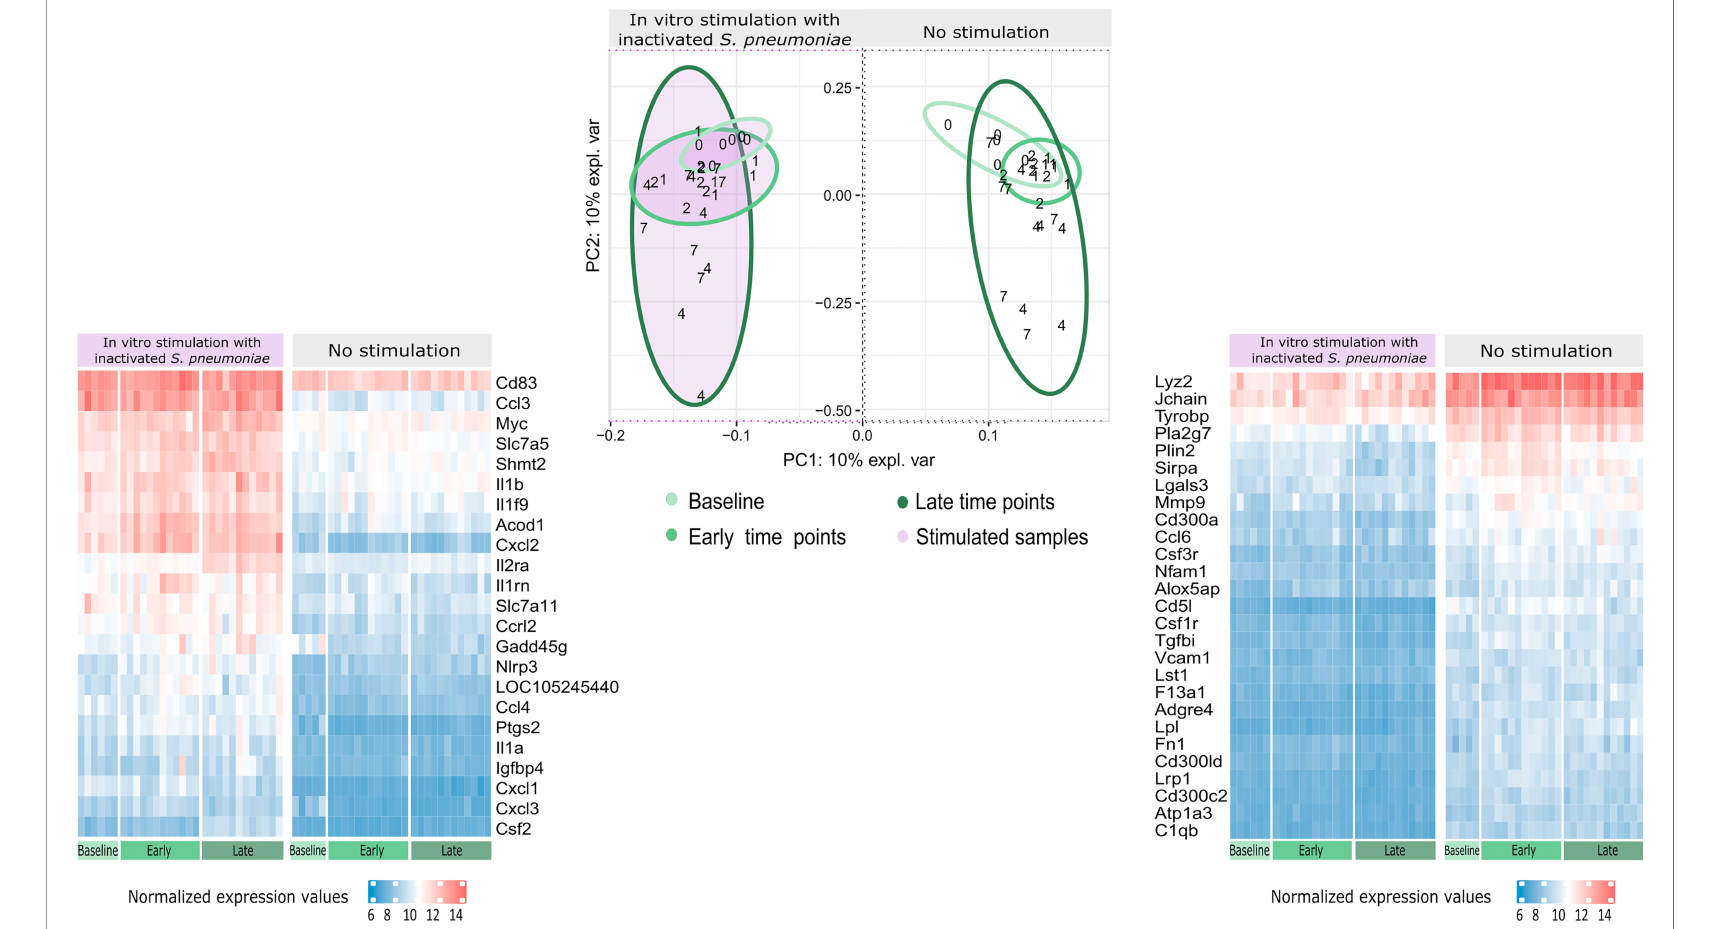
FIGURE 3 | Distribution of gene expression data and changes after stimulation. The sIPCA proposed by MixOmics revealed two main clusters, one formed by stimulated samples (shaded in purple) and other formed by unstimulated samples. The IPC1 (x-axis) represents the variance between stimulated and unstimulated samples of infected and non-infected mice. IPC2 (y-axis) shows the variance between baseline samples with respect to the other groups in different study days (1, 2, 4, 7). After infection, samples from days 1 and 2 (early time points) form a smaller cluster closer to baseline samples (lighter green), while samples from days 4 and 7 (late time points) present a higher dispersion (darker green). The normalized expression values for the 50 most important genes selected by the sIPCA in the fi rst component were represented in heatmaps, with lower values represented in blue and higher values in red and time points represented in the bottom part, following the same green scale of the sIPCA. The heatmap on the right, shows the 27 genes positively correlated with the fi rst component, which include positive and negative regulators of the immune system and drive the formation of the cluster of unstimulated samples. The heatmap on the left shows the 23 genes negatively correlated with the fi rst component, driving the stimulated samples to form a separate cluster. Most of these genes are related to cytokines and chemokines (Csf2, Ccl4, Il1a, Il1b, Il1rn, Il2ra, Cxcl1, Cxcl3, Cxcl2, Ccl3, Slc7a5) while others are related to immunity and in fl ammation (Cd83, Acod1, Slc7a11, Gadd45g, Nlrp3, Ptgs2 and